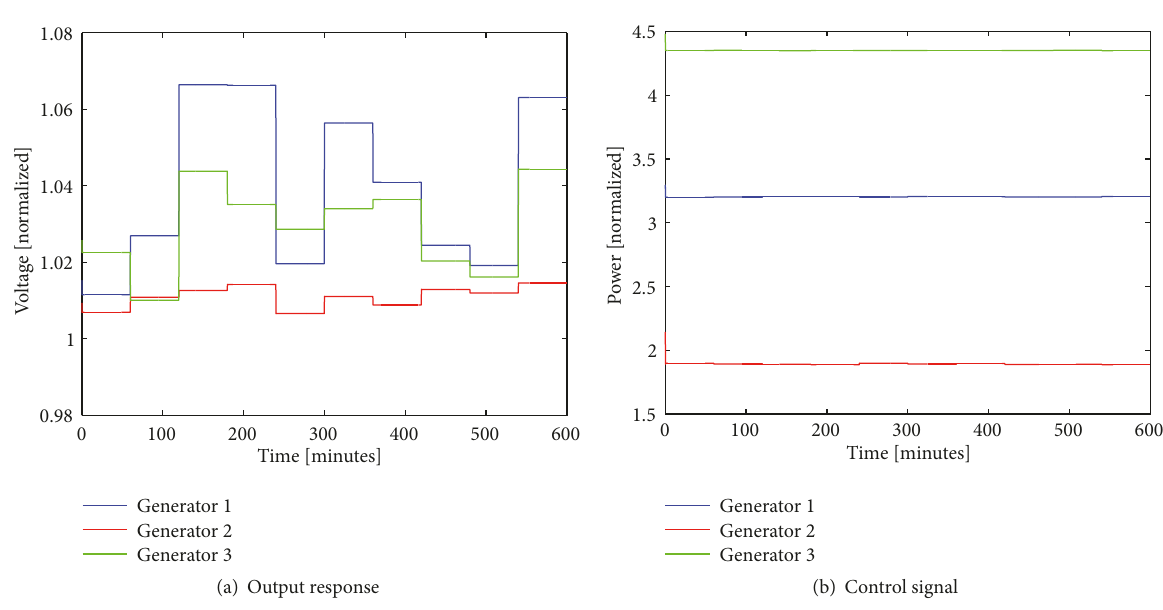
Figure 22: The response of the control system without the adaptation